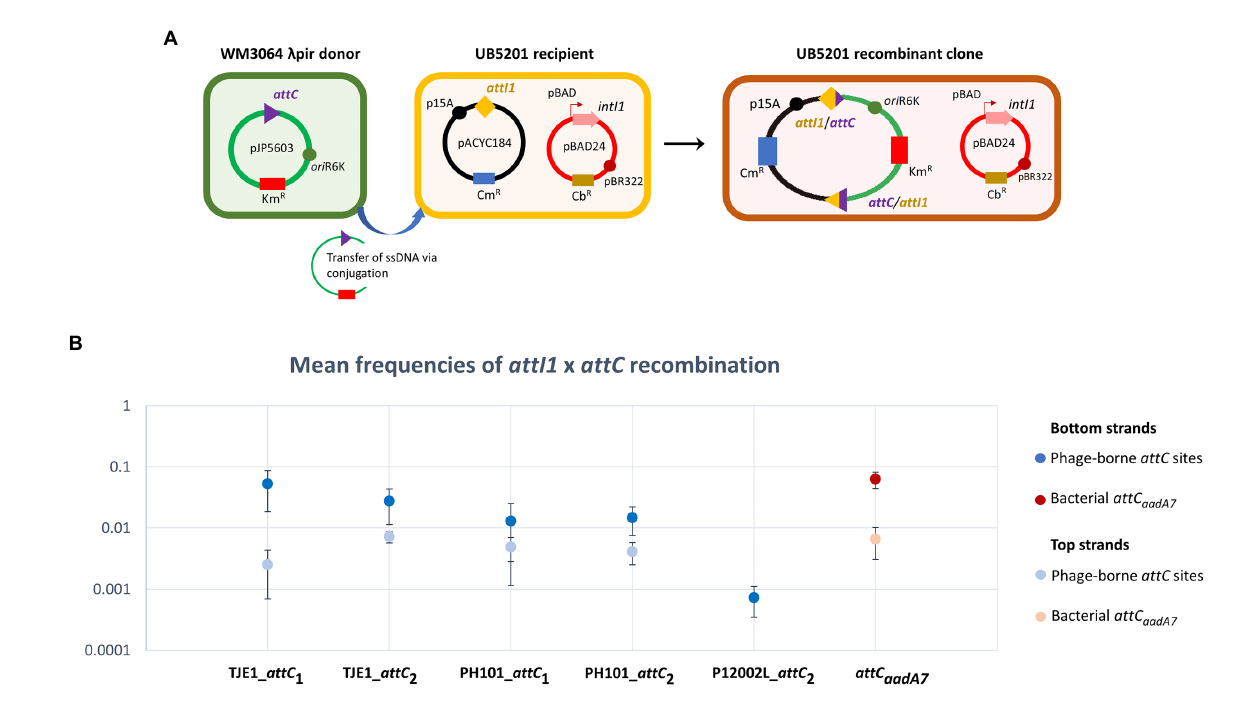
FIGURE 3 A panel of attC sites from virulent phages can be successfully recognized by the class 1 integron-integrase (IntI1) and incorporated into the canonical attI1 recombination site. (A) Schematic of the principles of the attC x attI recombination assay. During conjugation, the attC -containing pJP5603 plasmid is delivered into the UB5201 strain, which carries an L-arabinose inducible intI1 gene and an attI1 site on plasmids pBAD24 and pACYC184, respectively. The donor suicide vector cannot replicate within the recipient cells. It can only persist and confer kanamycin resistance following successful attC x attI recombination to form a co-integrate plasmid in the recombinant clone. (B) Mean recombination frequencies (± standard error of the mean) between attI1 and five virulent phage-borne attC sites. The bacterial attC aadA7 site was used as the positive control. Mean recombination frequencies were calculated from three independent sets of biological replicates. No statistically significant difference in mean recombination frequencies was detected across the six successfully integrated bottom strands of attC sites (one-way ANOVA: p = 0.189, F 5, 12 = 1.79). The mean recombination frequencies of the five successfully integrated top strands of attC sites were lower than those of the bottom strands. No recombinant clones were obtained for the top strand of P12002L_ attC 2